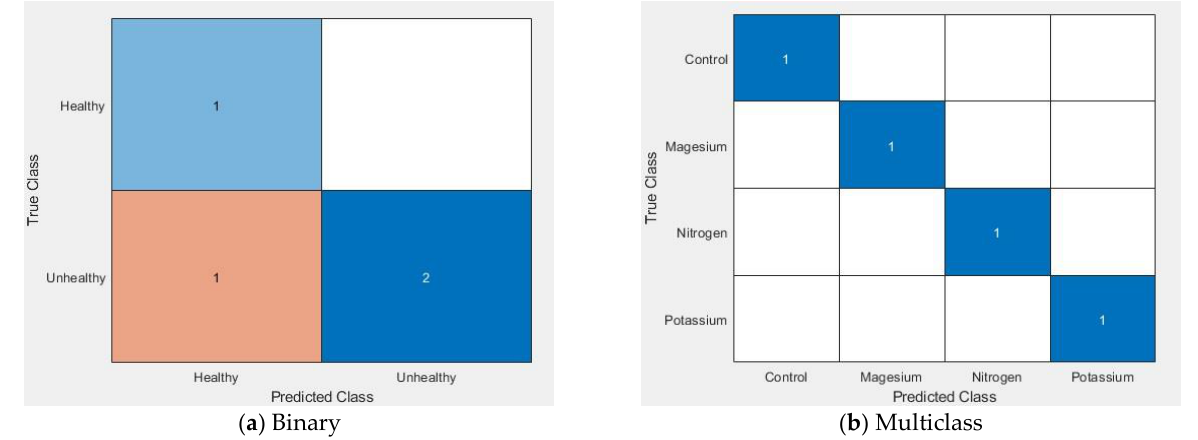
Figure 14. Confusion matrix for the binary and multiclass classifier.